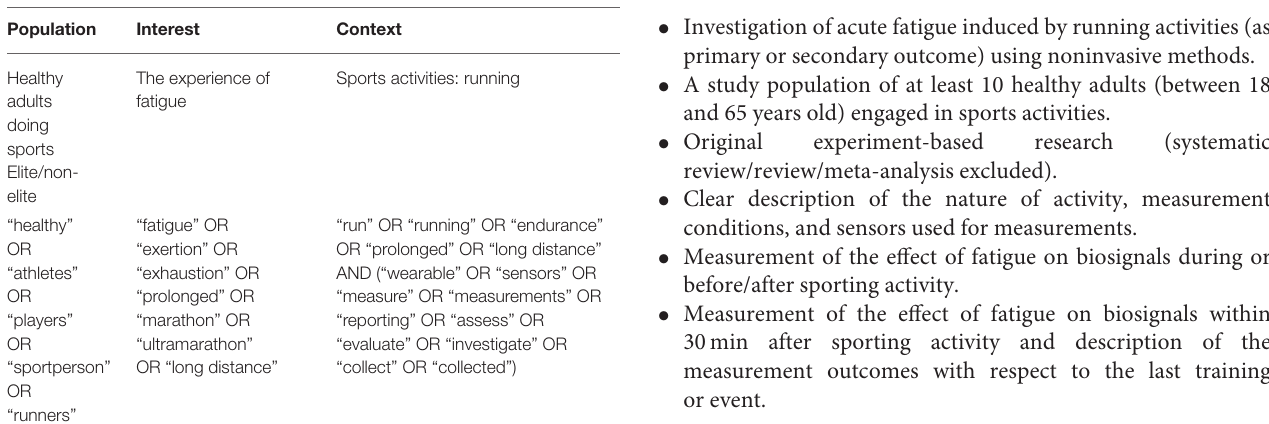
TABLE 1 | Details of the PiCO strategy used to conceptualize search